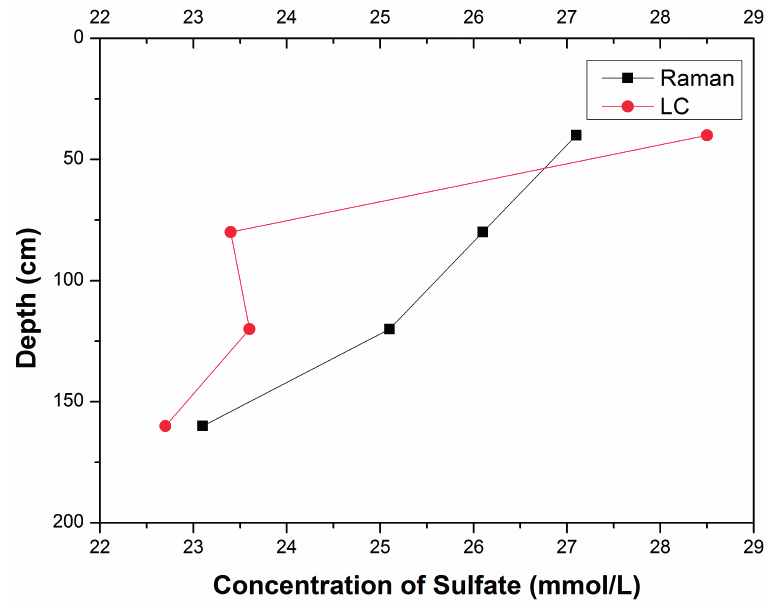
Figure 4. Profiles of SO 42 − concentrations in pore water measured by Raman spectroscopy and